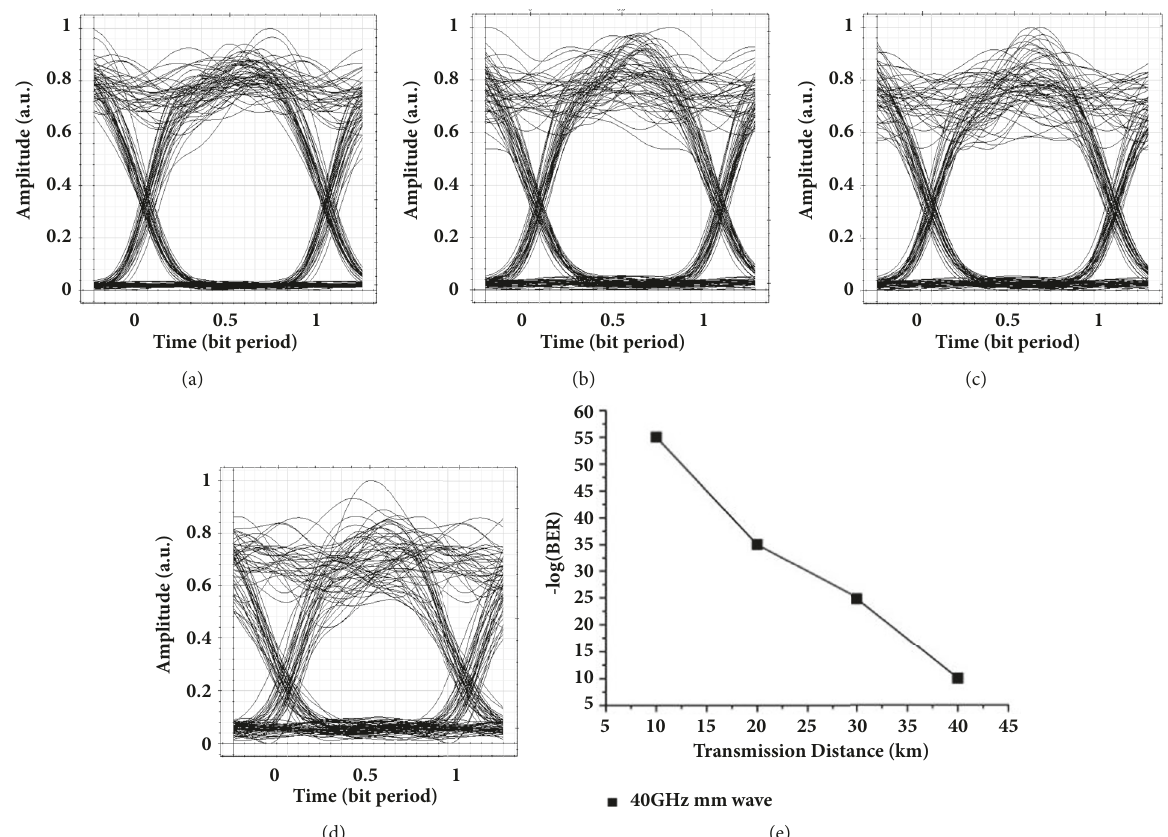
Figure 13: Baseband signal eye diagram of 40GHz mm-wave after fiber transmission over (a) 10 km, (b) 20 km, (c) 30 km, (d) 40 km, and (e) BER versus transmission